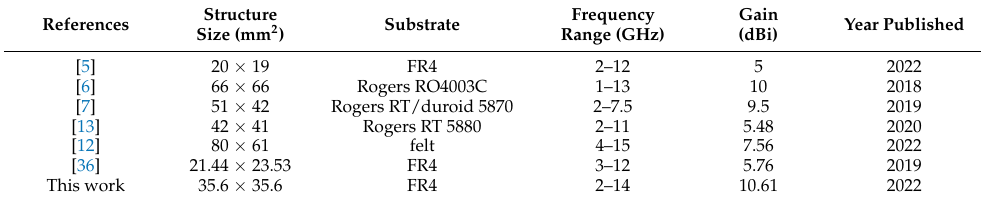
Table 3. Comparison between the proposed and existing works in terms of various